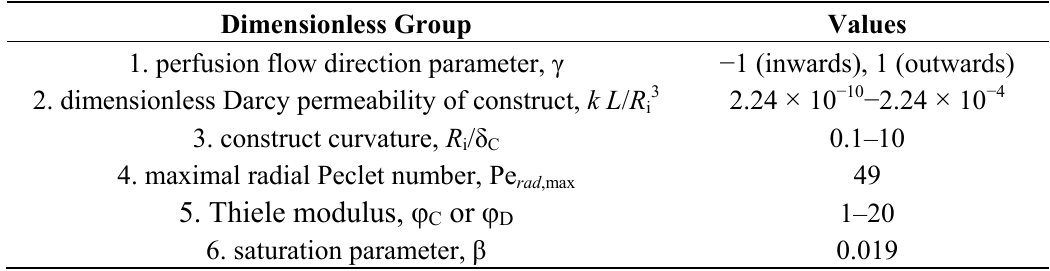
Table 2. Dimensionless group values used for model predictions, unless otherwise stated.